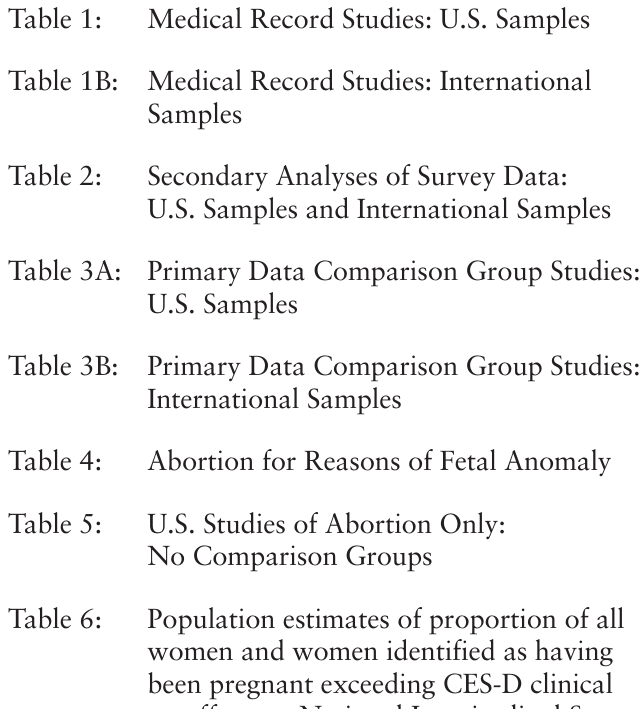
Medical Record Studies: U.S. Samples Medical Record Studies: International Samples Secondary Analyses of Survey Data: U.S. Samples and International Samples Primary Data Comparison Group Studies: U.S. Samples Primary Data Comparison Group Studies: International Samples Abortion for Reasons of Fetal Anomaly U.S. Studies of Abortion Only: No Comparison Groups Population estimates of proportion of all women and women identified as having been pregnant exceeding CES-D clinical cutoff score, National Longitudinal Survey of Youth: